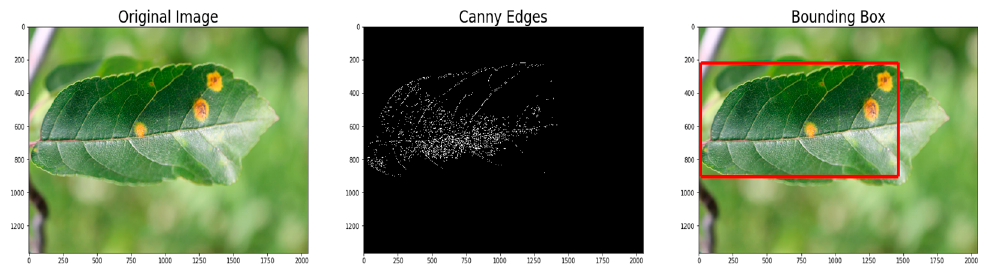
Figure 11. Output of Canny Edge Detection.